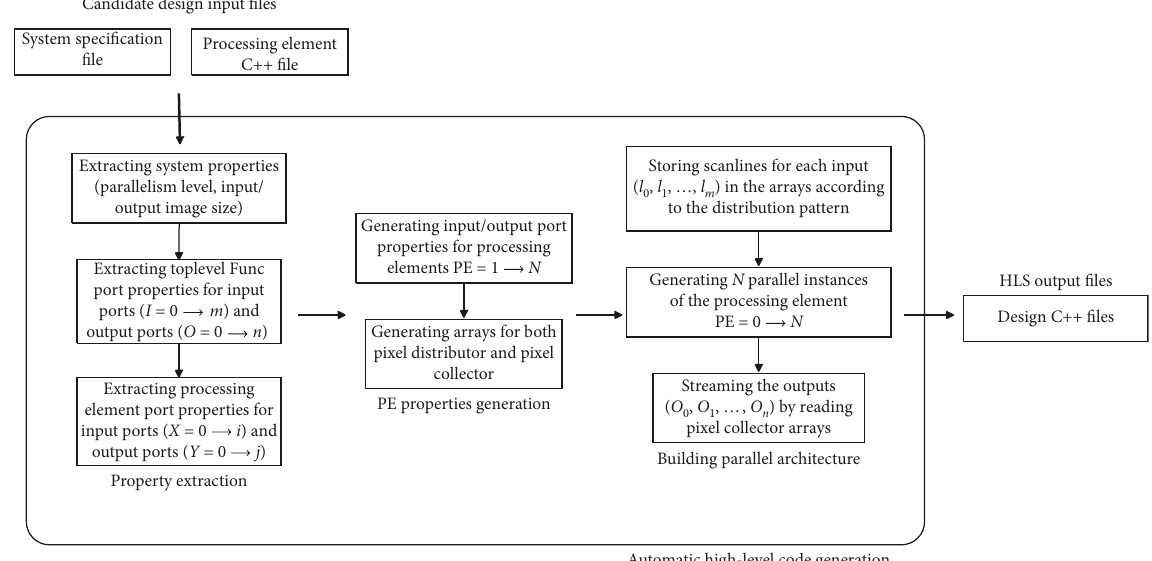
Figure 8: High-level code generation design